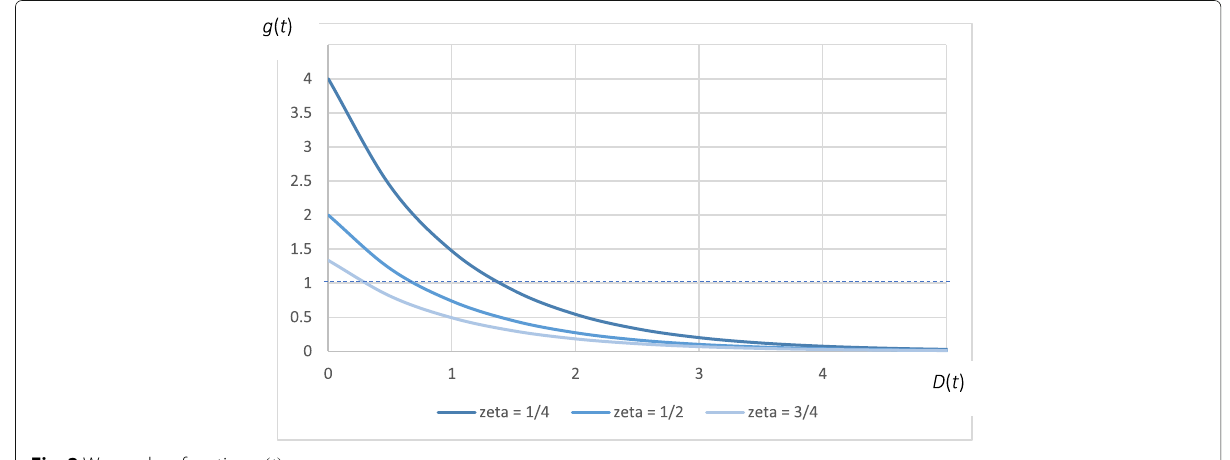
Fig. 2 Warm-glow function g ( t )